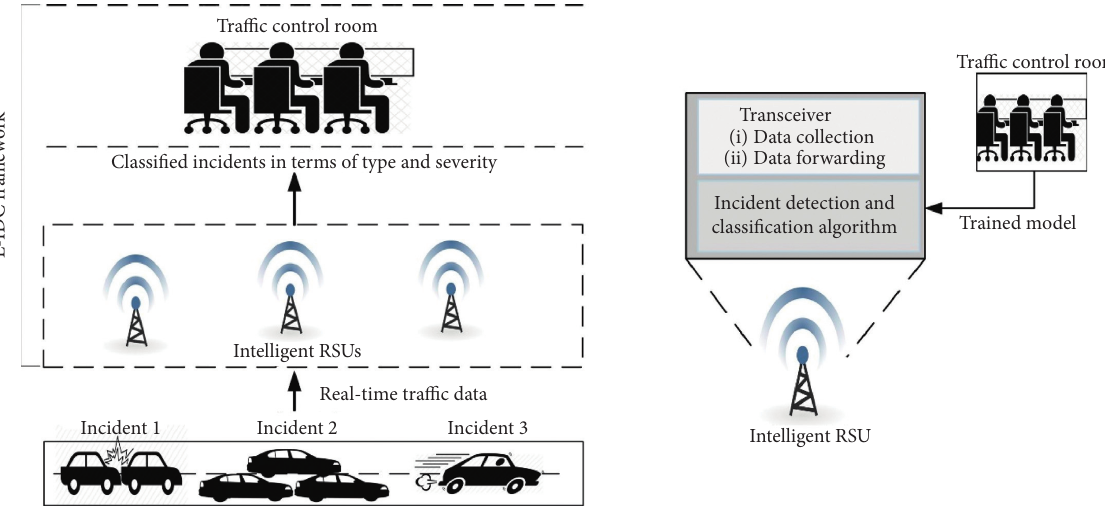
Figure 1: E-IDC framework (enhanced